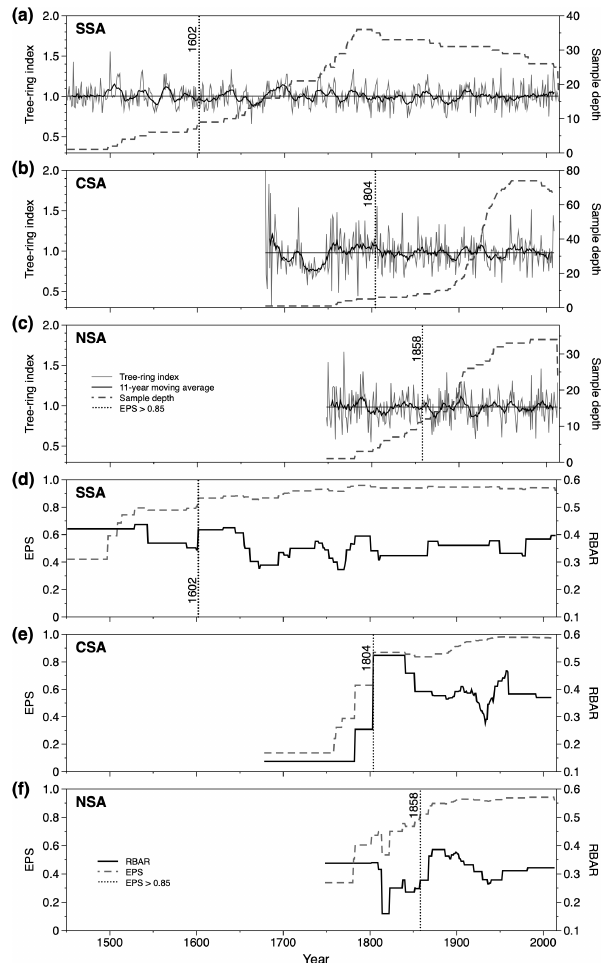
Figure 3. Variations in the tree-ring width chronologies and sample depth (a–c) , expressed population signal (EPS) and average corre- lation between all series (RBAR) (d–f)